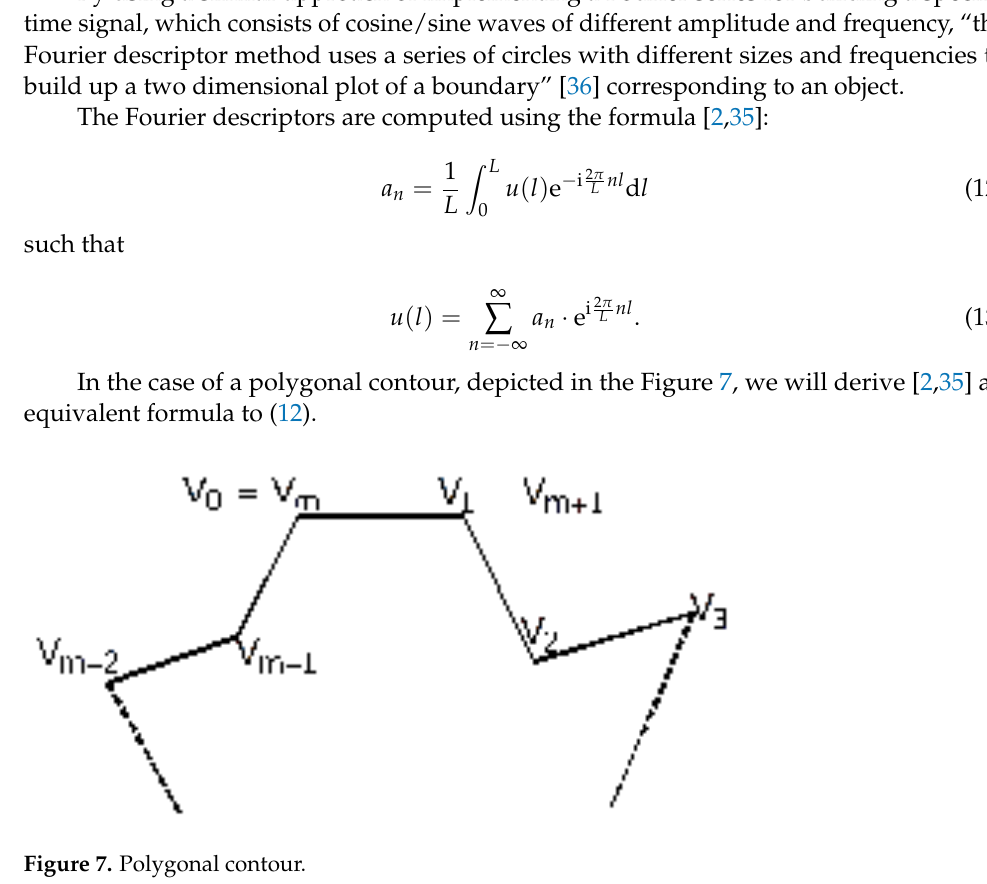
Figure 7. Polygonal